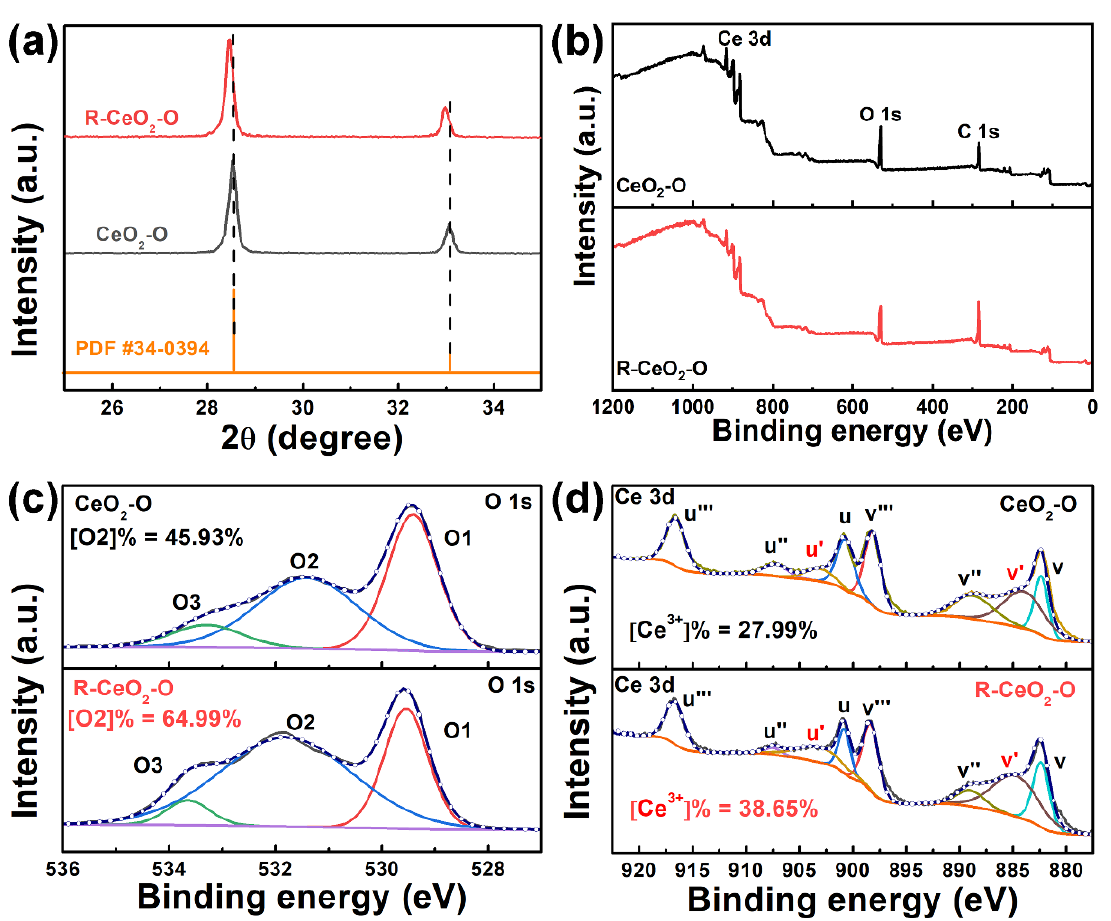
Figure 2. ( a ) Raman, XPS ( b ) survey, ( c ) O 1s, and ( d ) Ce 3d spectra of CeO 2 -O and R-CeO 2 -O.